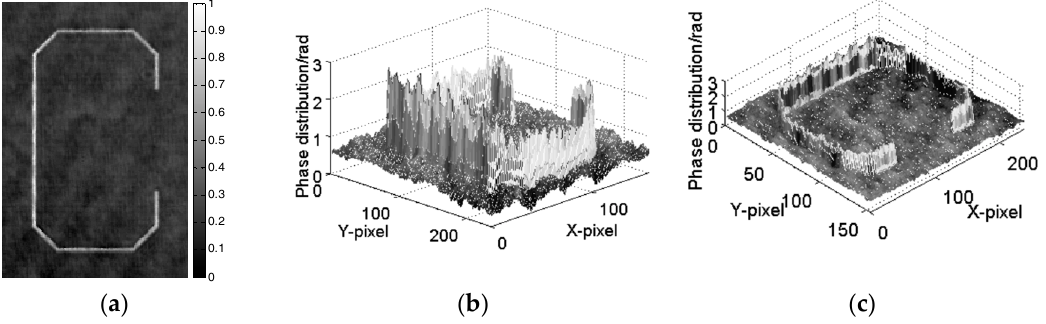
Figure 7. Phase retrieval results with zeroth-order term still existing. ( a ) Retrieved phase map in grayscale with zeroth-order term; ( b ) Left view of 3D reconstructed phase distribution; ( c ) Right view of 3D reconstructed phase distribution.